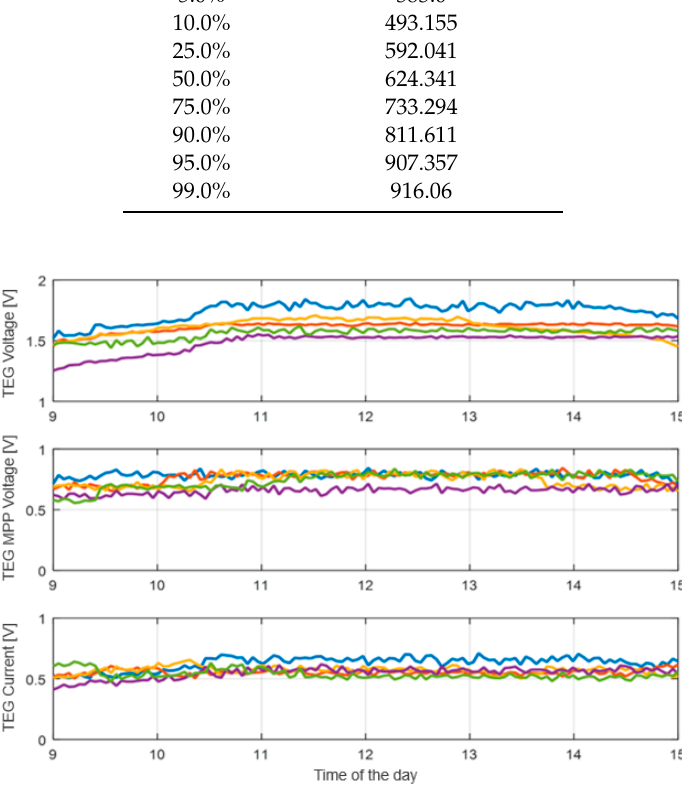
Figure 23. Measurements of output waveforms.